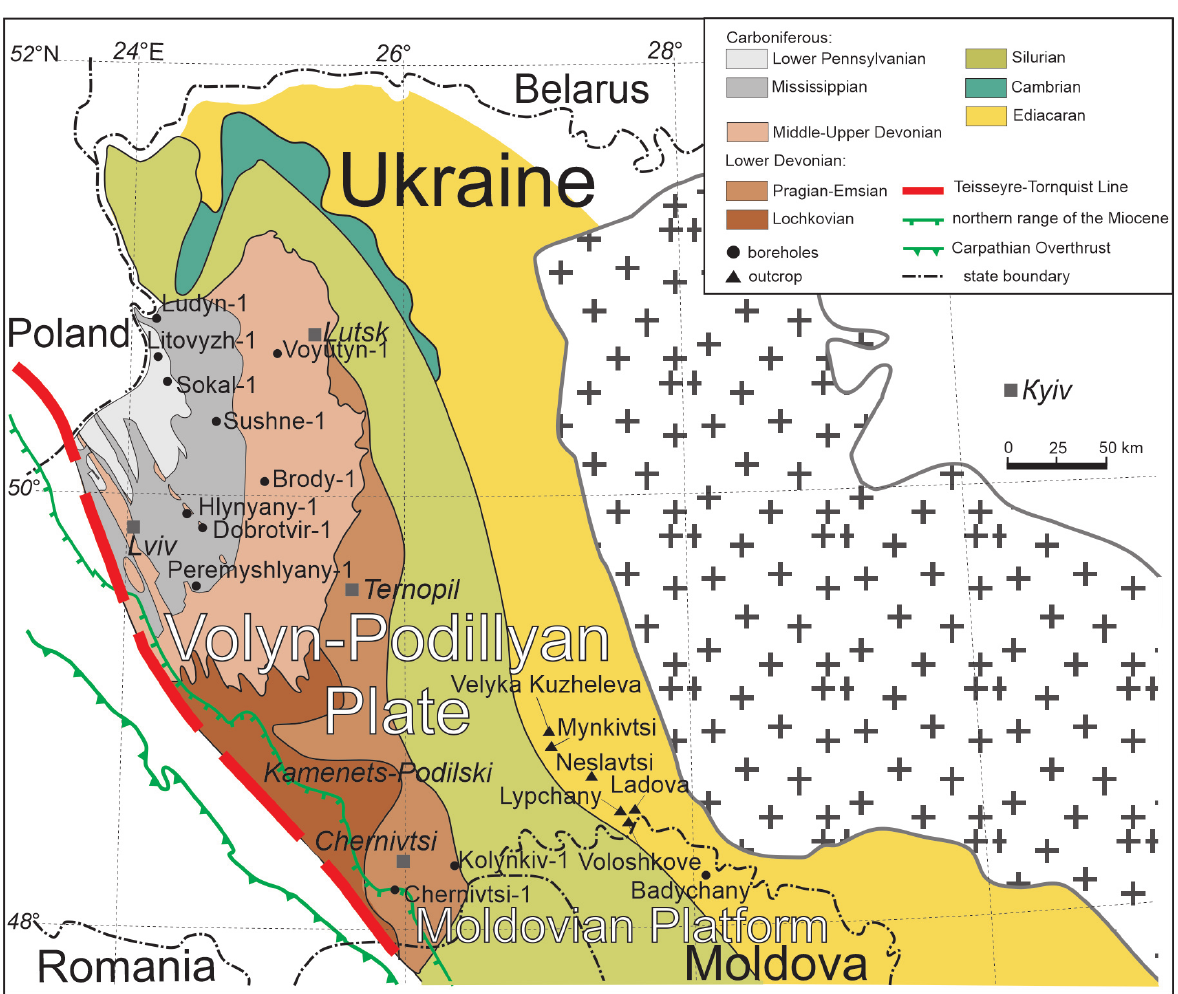
Fig. 3. Geological map of the southwestern margin of the East European Platform without the Mesozoic and Cenozoic